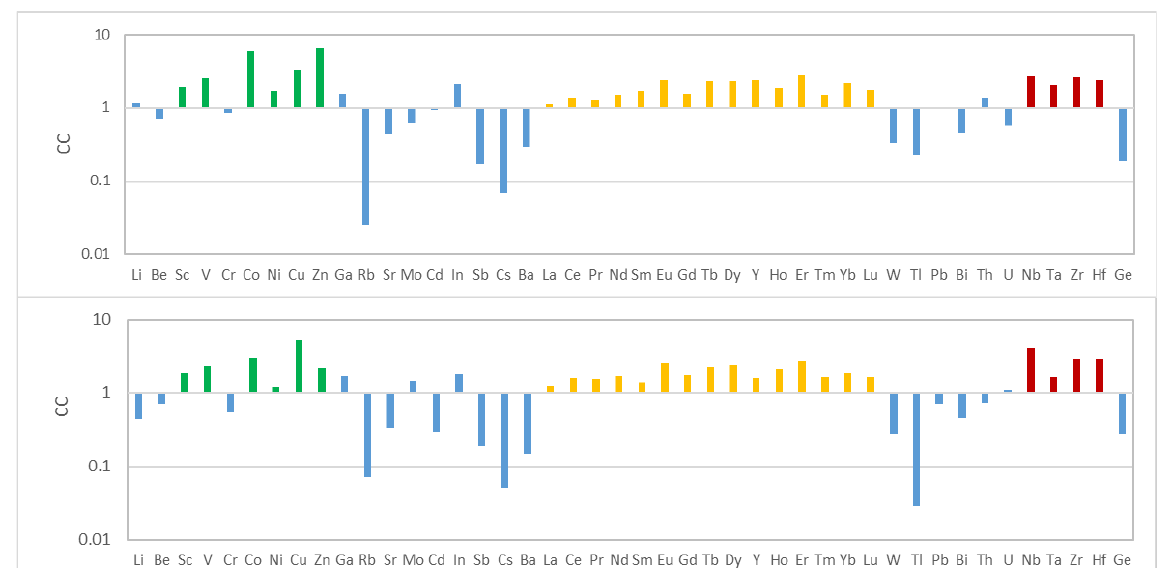
Figure 4. Concentration coefficients of critical elements of the two coal seams. Note: Concentration coefficients of critical elements of coal samples are the ratios of determined values of this study to the average value of most world coals or most world clays. The upper graph shows the average concentration coefficients of the samples of the C4-Upper coal seam, and the lower graph shows the average concentration coefficients of the samples of the C5 + 10 coal